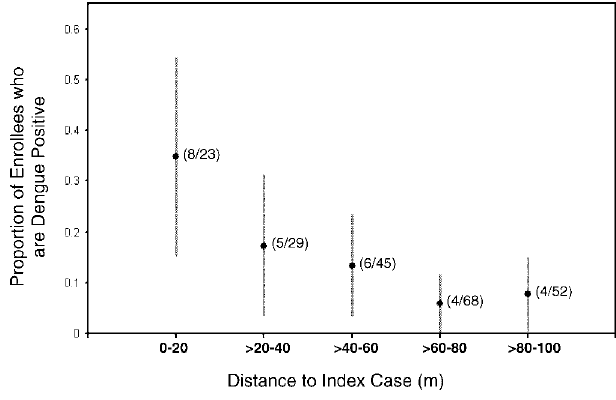
Figure 3. Clustering of DENV Infections within Positive Clusters This graph shows the relationship of distance between the houses of enrollees and the index case in the positive clusters and the proportion of those enrollees that experienced DENV seroconversion. Error bars represent 95% CIs of the proportions. Numbers in parenthesis indicate the number of positive enrollees and the total number of enrollees in each distance interval. The relationship between distance and the proportion of enrollees that are dengue positive was significant (Fisher’s exact test, p , 0.001).